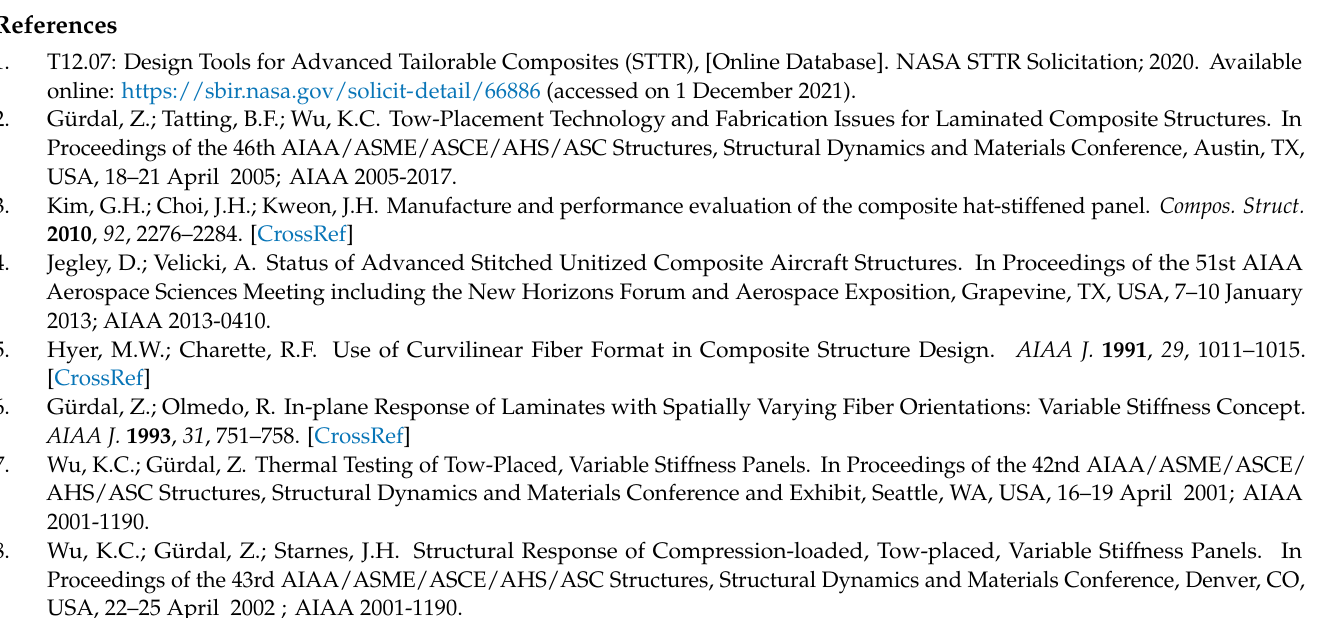
Figure A1. Comparison of axial stress (unit: N/m 2 or Pa) of the stiffeners under different loading conditions. ( a ) In-plane axial displacement; ( b ) in-plane shear displacement; ( c ) in-plane bending